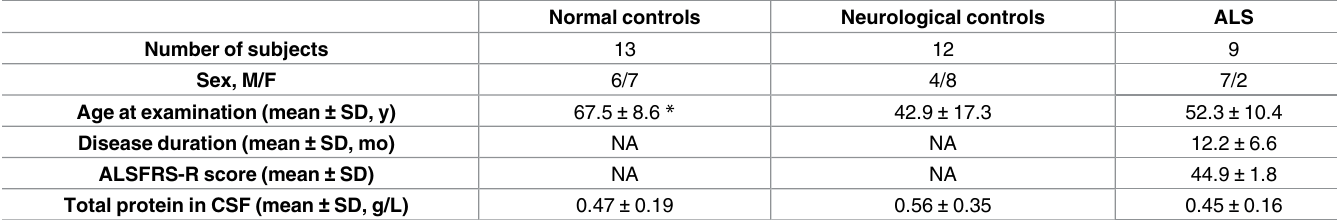
Table 1. Clinical characteristics of study participants.